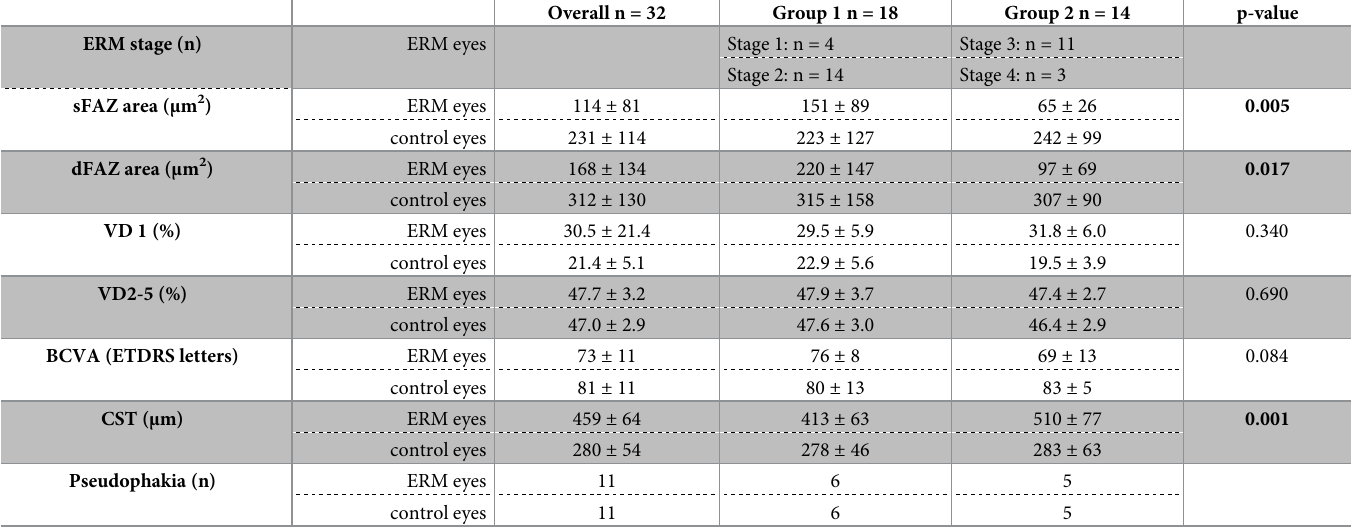
Data are presented as the mean ± SD; Data presented are grouped based on severity; Group 1 comprises ERM stages one and two, Group 2 comprises ERM stages three and four. P-value indicates changes between Groups 1 and 2 in ERM eyes.